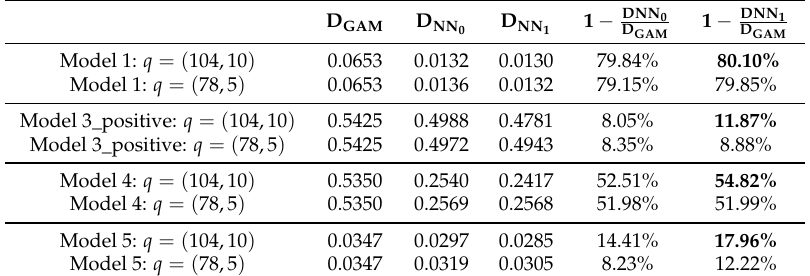
Table 4. Minimal cross-entropy and deviance loss functions on validation sets observed during the training of the neural networks in k = 16. D